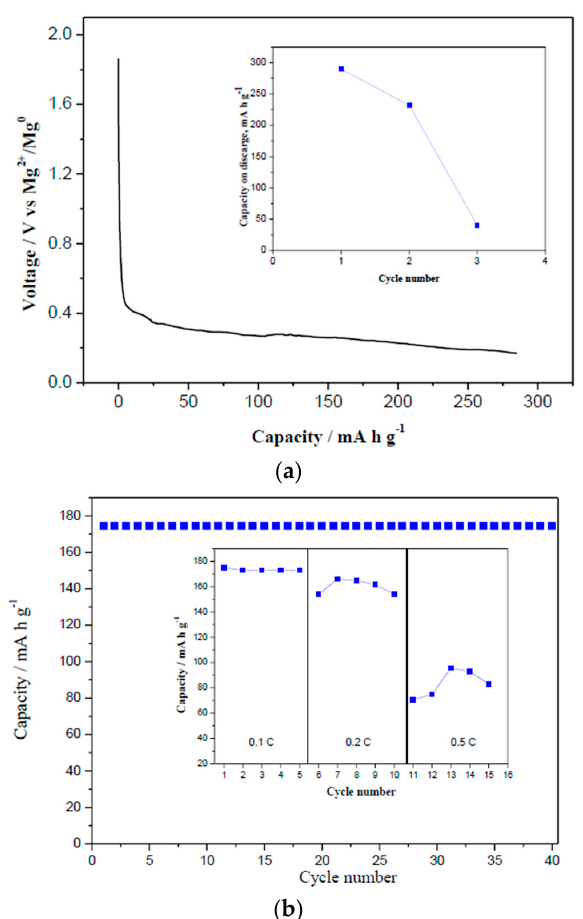
Figure 4. ( a ) Discharge curve of LTO until 290 mA h g − 1 representing the reaction of magnesium with LTO using 0.5 M Mg(TFSI) 2 + 0.13 M MgCl 2 ·6H 2 O in DME electrolyte. Representative curve obtained for LTO/Mg cell for ex-situ XRD and XPS analysis. The inset in ( a ) represents the capacity retention during 3 cycles. ( b ) Capacity retention of LTO in Mg cell using 0.5 M Mg(TFSI) 2 + 0.13 MgCl 2 ·6H 2 O in DME electrolyte with capacity cut-off. The inset in (b) represents the rate performance with voltage cut-off.